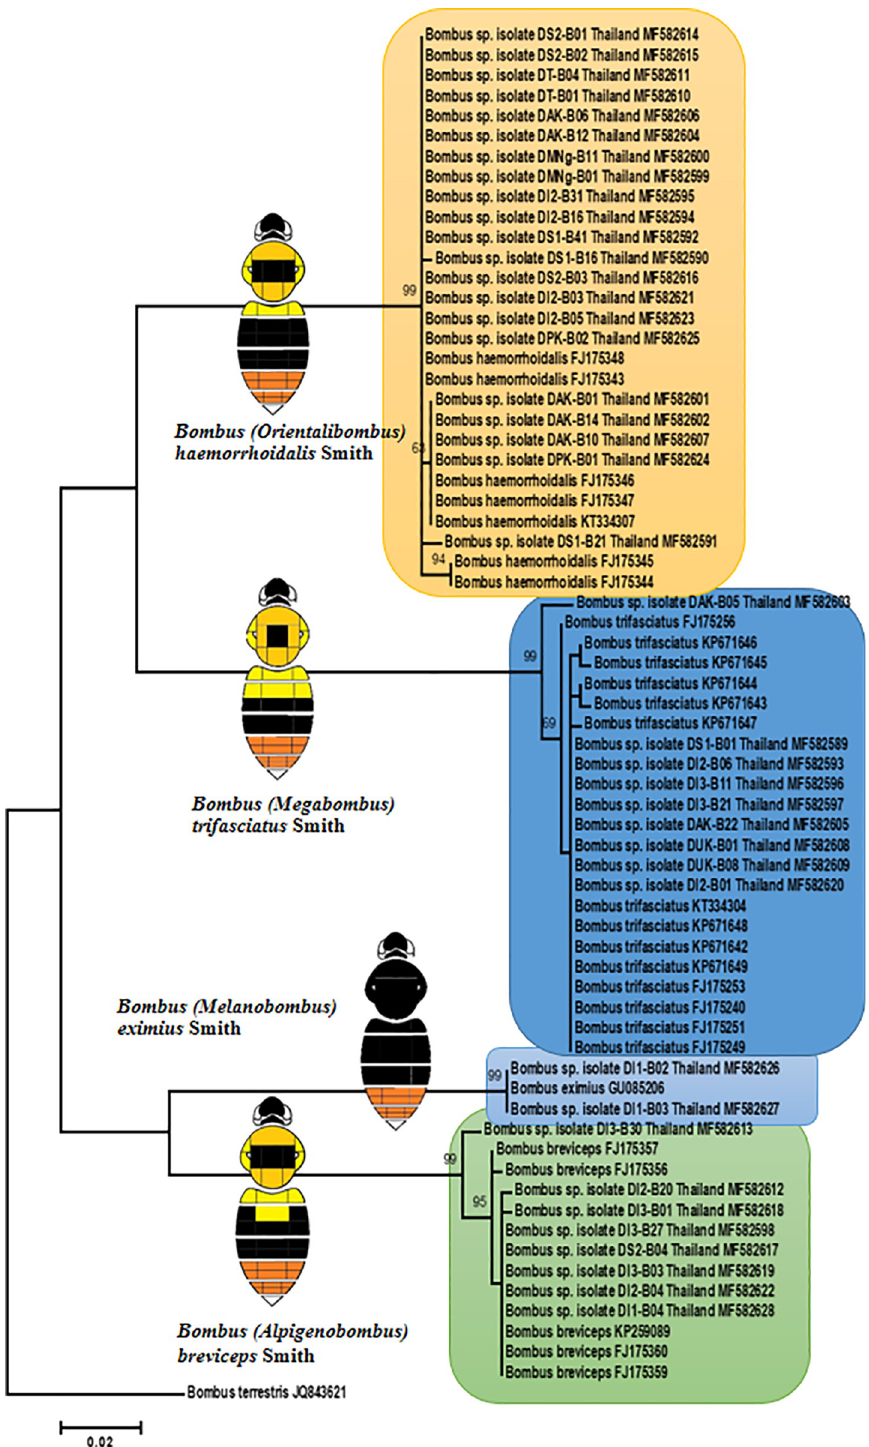
Fig 3. Estimate of phylogenetic relationship of cytochrome oxidase subunit I (COI) from bumblebees ( Bombus sp.) collected in northern Thailand using maximum likelihood. The sequences of B . terrestris –JQ843621 was used as an out group. Numbers at each node represent bootstrap values as percentages and only bootstrap values greater than 70% are shown.